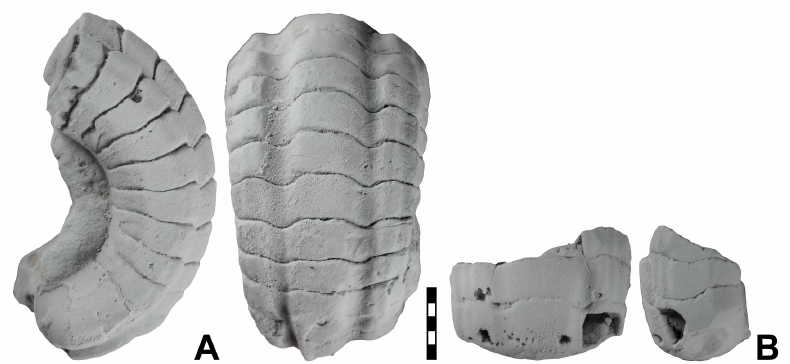
Fig. 23. Trilobitoceras peculiaris sp. nov. from Oued Temertasset (both Korn et al . 2002 Coll.). A . Holotype MB.C.30477. B . Paratype MB.C.30478. Scale bar units = 1